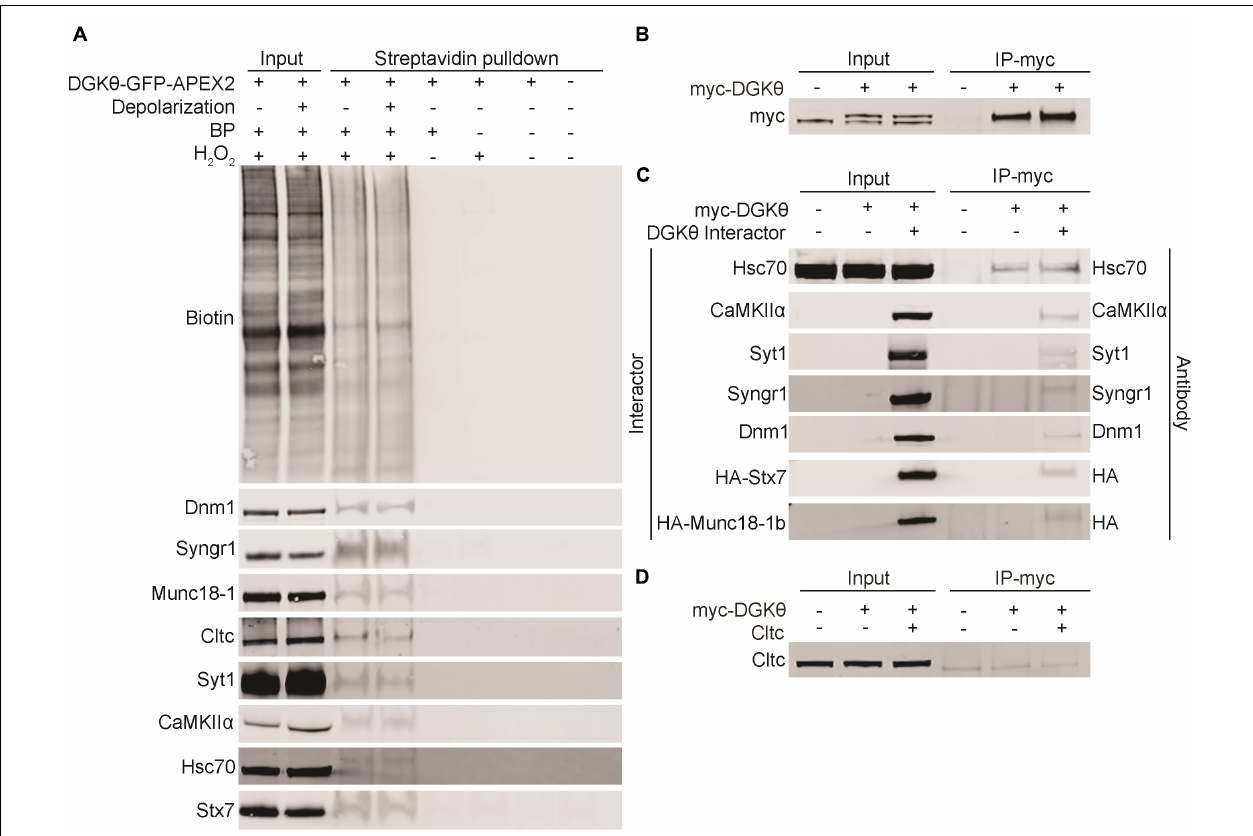
FIGURE 4 | Validation of candidate DGK θ -interacting proteins. (A) Streptavidin beads were used to isolate biotinylated proteins from DGK θ -GFP-APEX2 labeled cortical neuron lysates (DIV21), and biotinylation was confirmed biochemically for dynamin-1, synaptogyrin-1, Munc18-1, clathrin heavy chain 1, Syt1, CaMKII α , Hsc70, and syntaxin-7. (B) DGK θ overexpressed in HEK cells is immunoprecipitated with a myc antibody. (C) DGK θ interacts with Hsc70, CaMKII α , Syt1, synaptogyrin-1, dynamin-1, syntaxin-7, and Munc18-1 when both are overexpressed in HEK cells. Hsc70 interacts with DGK θ at its endogenous expression level. (D) Clathrin heavy chain 1 does not interact with DGK θ when overexpressed in HEK cells. All blots are representative of at least three separate experiments.